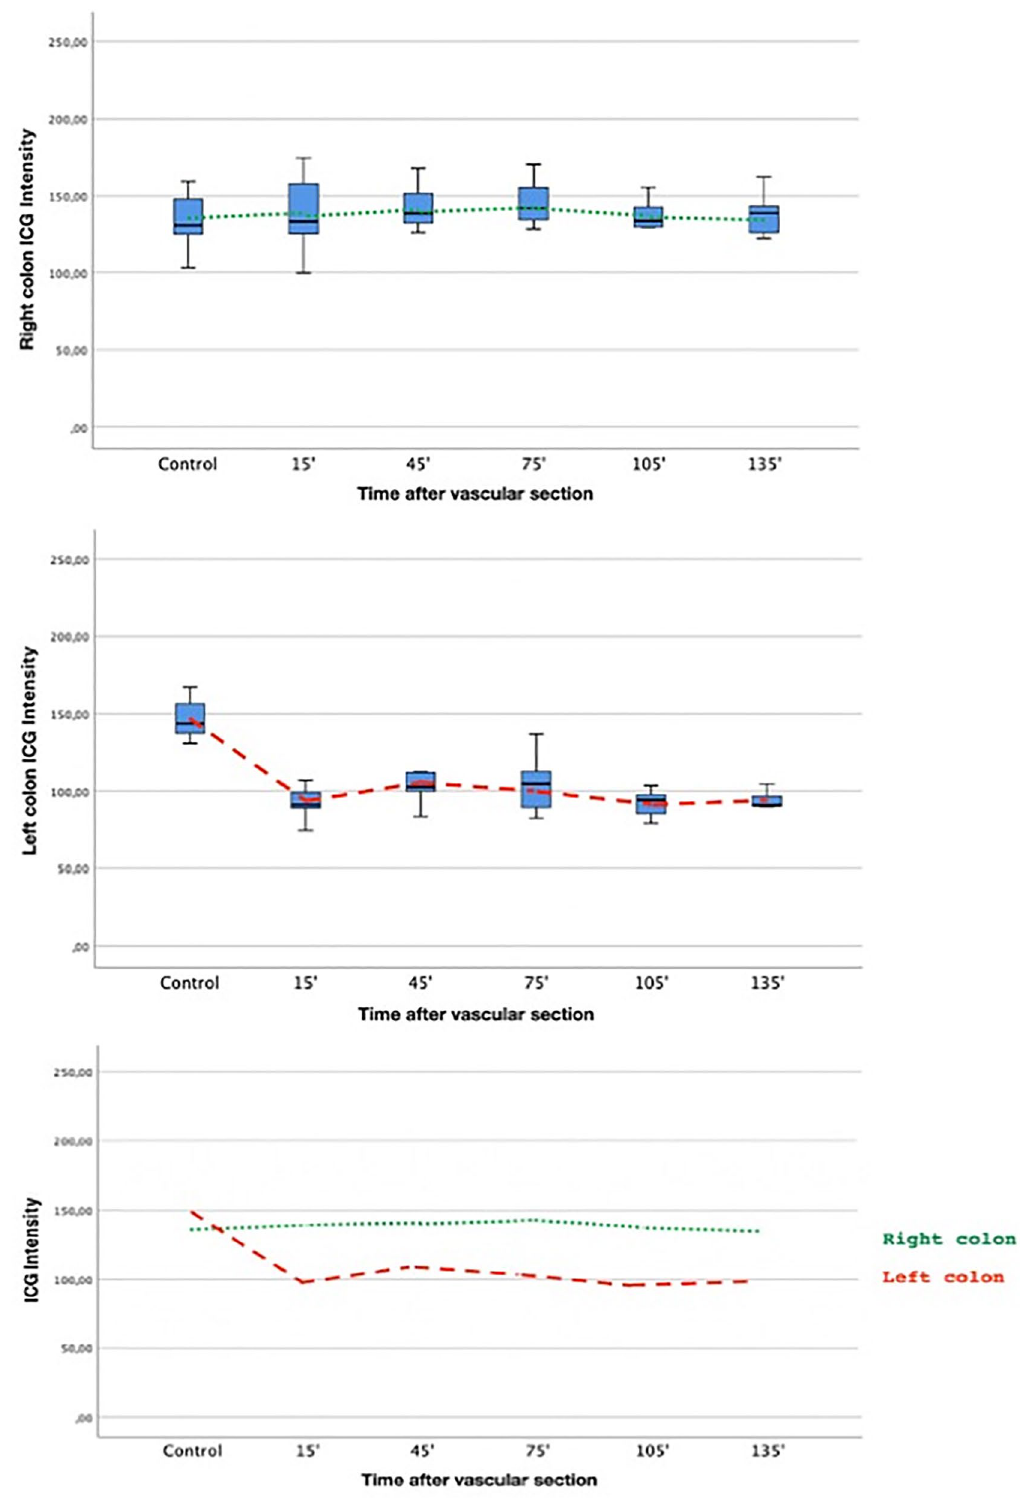
Figure 4. Boxplot showing the evolution over time from baseline prior to the section of the IMA to minute 135 after its section and that of the vein at the level of the right (1) and left (2) colon. The overlap of the two evolutions over time can be seen in graph 3, where the solid line represents right colon and the dashed line the